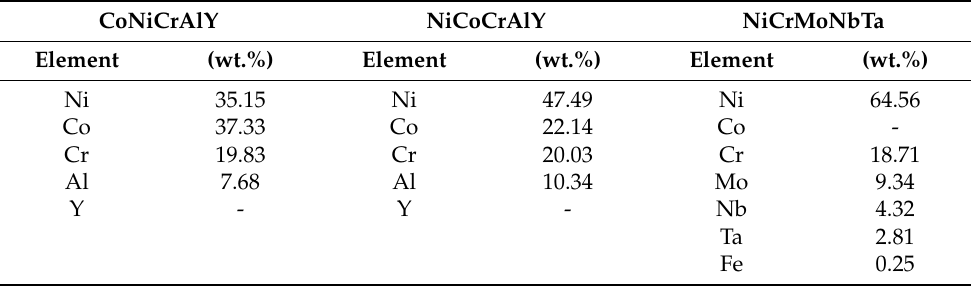
Figure 5. Coatings cross sections: ( a ) CoNiCrAlY, ( b ) NiCoCrAlY, ( c ) NiCrMoNbTa, SEM-EDS (spot analysis are given in Table 3). Table 3. Chemical composition of coatings estimated in spots marked in Figure 5,